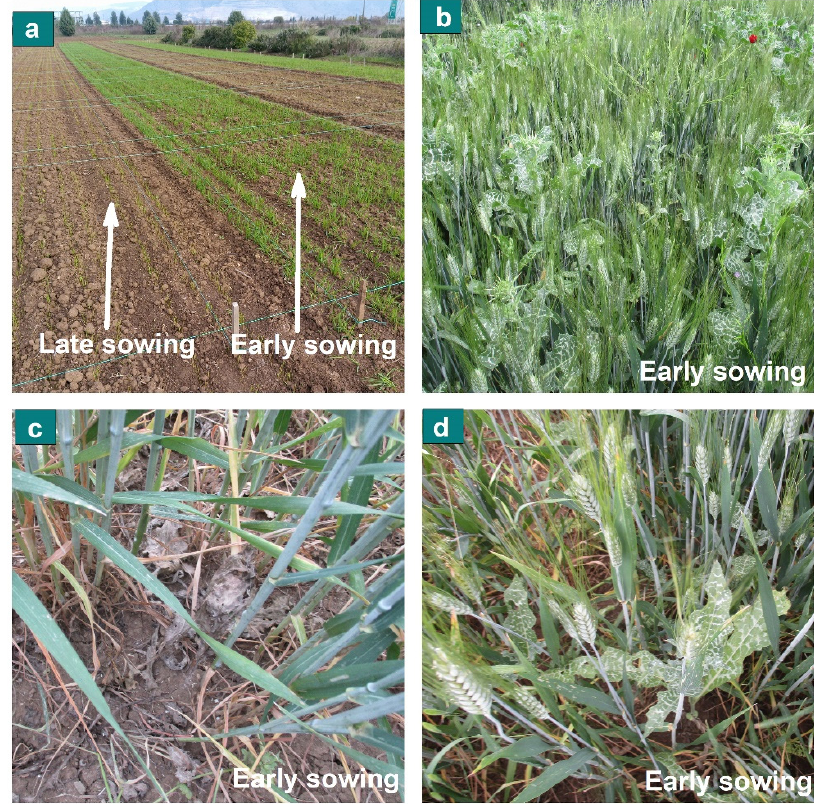
Figure 5. ( a ) Experimental field in early December of 2019, ( b ) milk thistle density in weed-infested plots (5 May 2020), ( c ) necrosis of milk thistle plants in the bromoxynil + 2,4-D treatment (5 May 2020), and ( d ) milk thistle plant growth in tribenuron-methyl plots (5 May 2020).